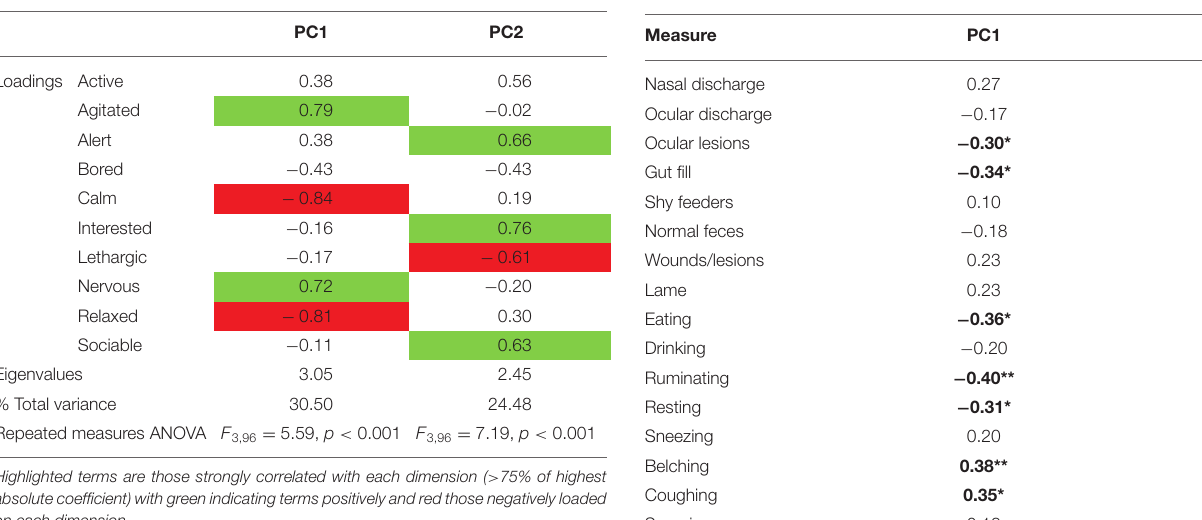
TABLE 3 | Spearman’s rank correlation results between PC factors for PC1 and PC2 and real-time measures, with significant results ( p < 0.05)